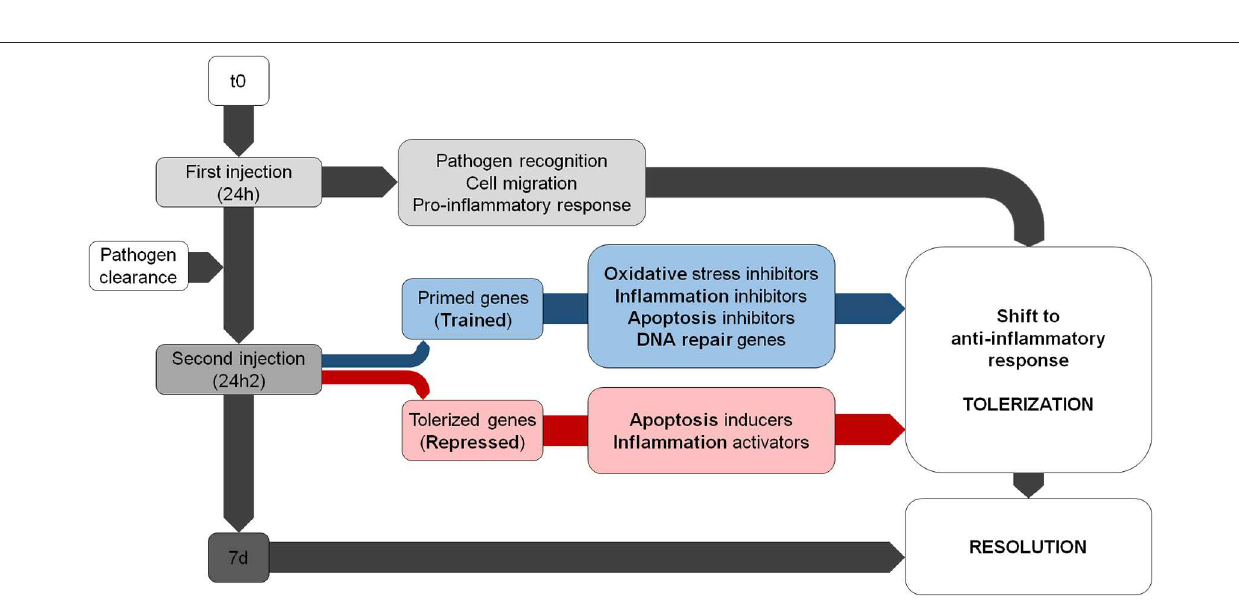
Frontiers in Immunology | www.frontiersin.org